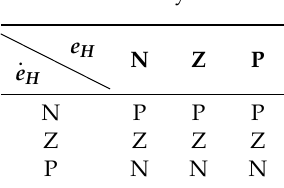
Figure 8. Membership function (MF) of input-output in fuzzy-PID, ( a ) MF of input 𝑒 (cid:3009) , ( b ) MF of input 𝑒(cid:4662) (cid:3009) and ( c ) MF of output 𝑈 . Table 2. Fuzzy rules.